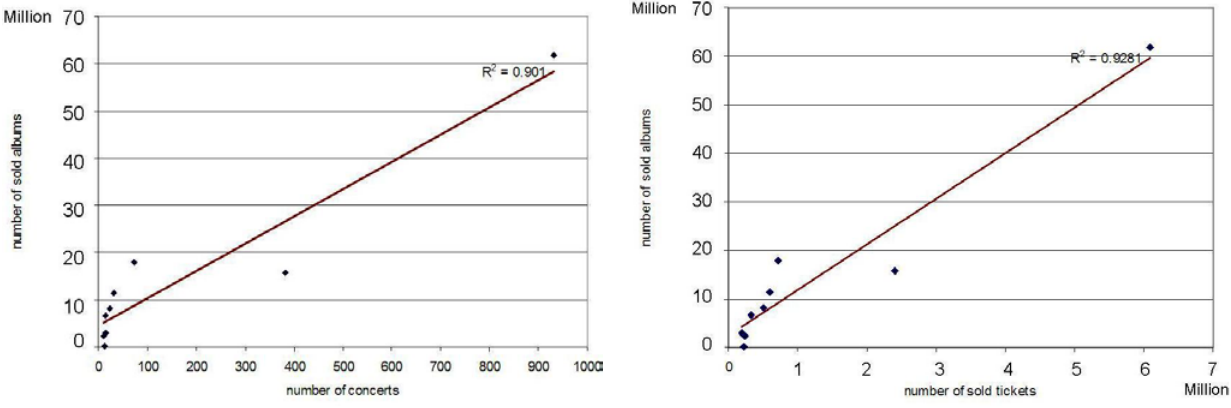
Figure 1: Pearson correlation between sold albums Figure 2: Pearson correlation between sold albums and the number of conce rts and the sold tickets to live concert